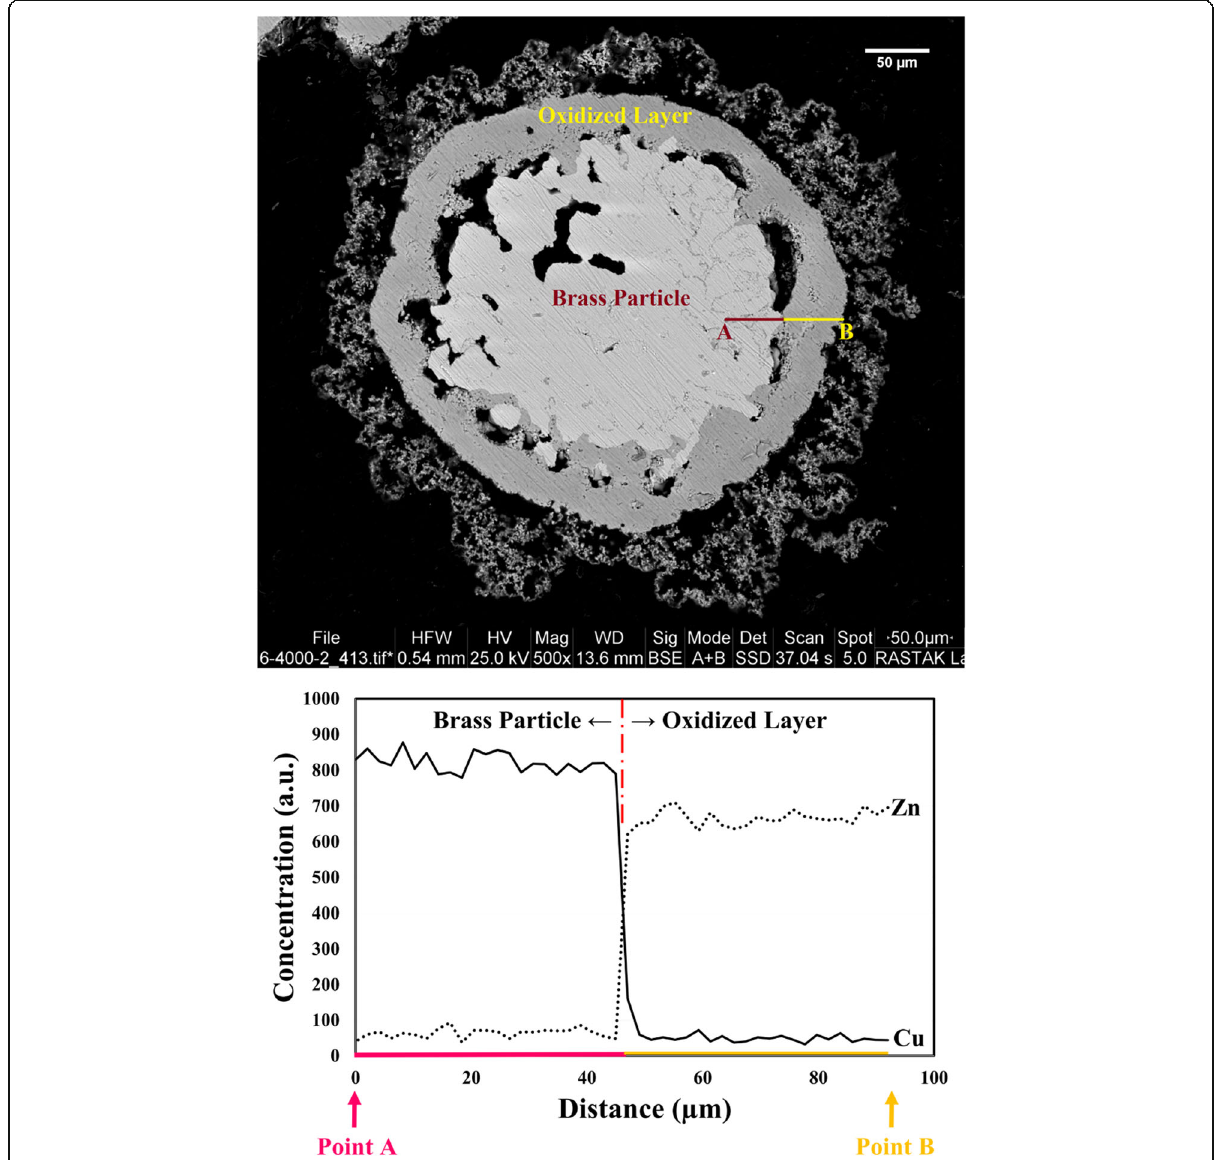
Fig. 2 The cross-section of a brass alloy particle, partially oxidized at 850 °C in the air for 3 h. a SEM image from the cross-section, ( b ) the elemental line analysis across line A-B in Fig.